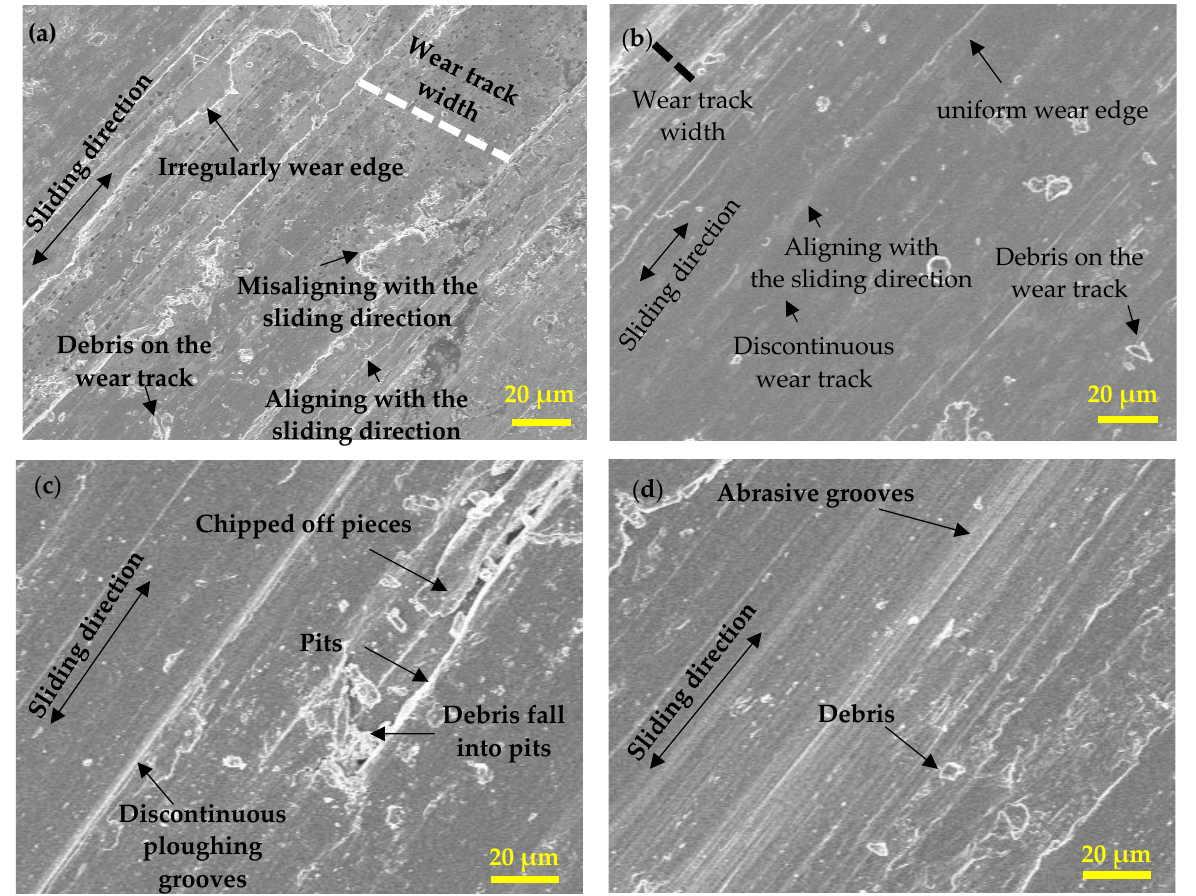
Figure 7. Analysis of wear track width and debris: ( a , b ) CACF and SLM specimens. Analysis of worn out surface of: ( c , d ) CACF and SLM specimens at 50N load with 1.2m/s sliding speed.